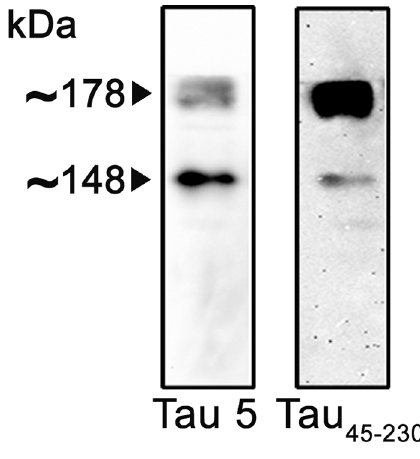
aggregates Figure 3. Detection of tau 45-230 in ALS spinal cord samples. Homogenates of lumbar spinal cord samples obtained from ALS subjects were analyzed by means of native/nondenaturing PAGE followed by Western blot. Membranes were reacted with a nonphosphorylation- dependent tau antibody (clone tau5) and stripped and reprobed with a tau specific antibody. 45-230 Two tau immunoreactive bands were 45-230 detected in ALS